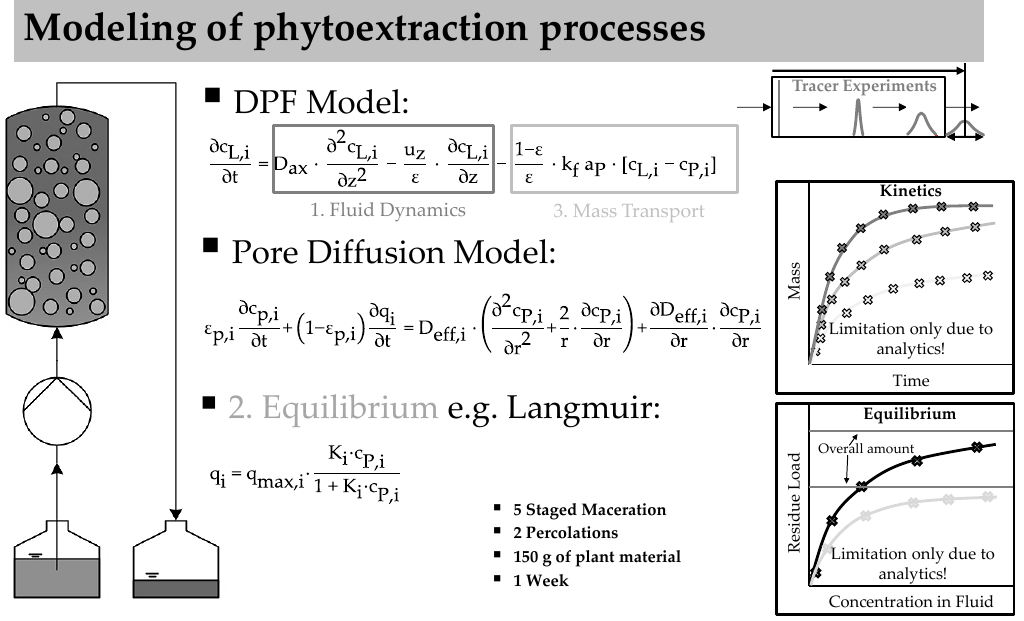
Figure 6. Stepwise equation assembly in phytoextraction (solid liquid extraction).